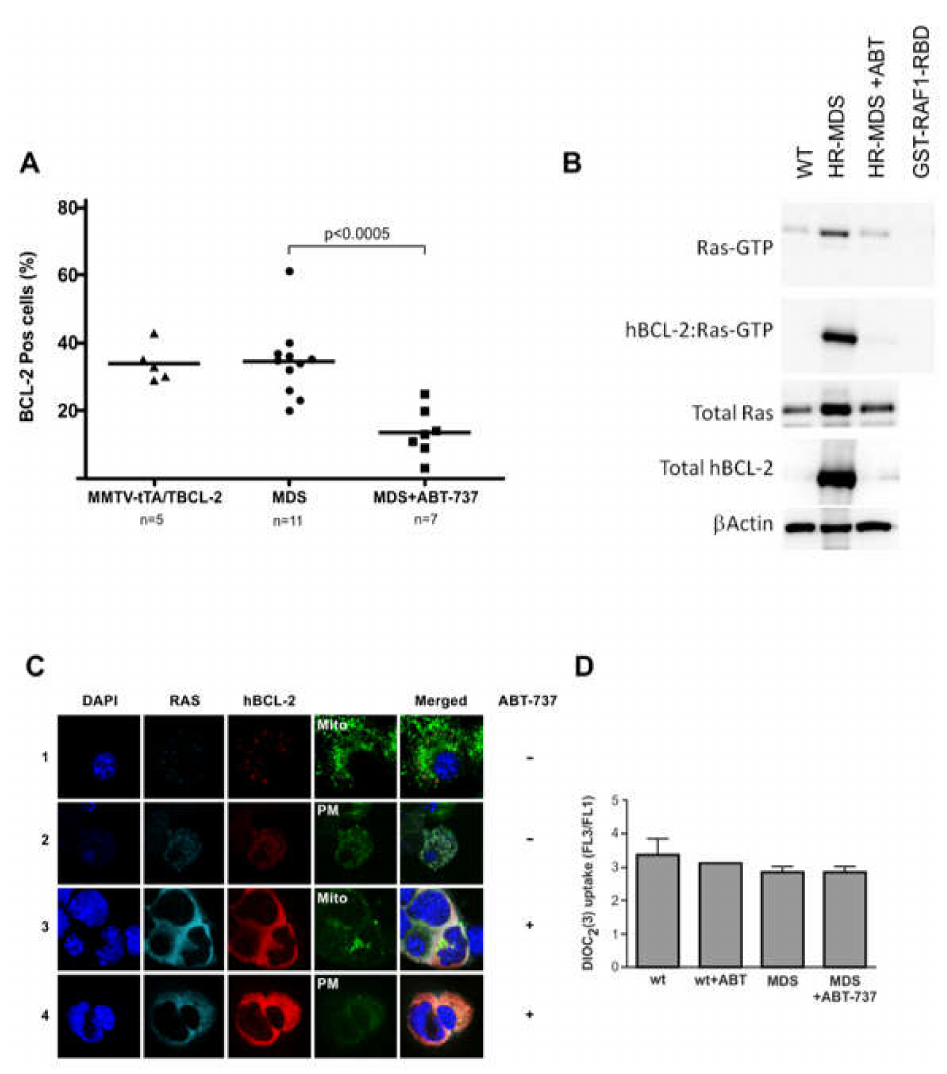
Figure 3. Inhibition of BCL-2 reduces BCL-2 expression and RAS activity in Sca-1+ cells. ( A ) Percentage of peripheral blood hBCL-2 positive (pos) cells in MMTV-tTA/TBCL-2 mice ( n = 5) compared to untreated HR-MDS mice ( n = 11), compared to treated HR-MDS mice ( n = 7), showing a significant decrease of BCL-2 positive cells after treatment p < 0.0005; ( B ) Representative Western blot analysis of protein lysates from Sca-1+ enriched spleen cells of untreated, 75 mg/kg ABT-737 treated mice after day 33 of treatment and assessed for total RAS and hBCL-2 expression showing a decrease in RAS-GTP. Blots were reprobed with anti β -Actin antibody to assess protein loading. n = 3 mice were assayed; ( C ) Confocal microscopy of stained BM cells showing subcellular localization of the NRAS:BCL-2 complex of HR-MDS mice in the plasma membrane in untreated HR-MDS mice (rows 1 & 2) and in treated HR-MDS mice (rows 3 & 4). Mitochondria stained with Tom20 antibody, plasma membrane stained with anti-Ezrin antibody. n = 2 mice were assayed. ( D ) Mitochondrial membrane potential measurements of splenocytes by DiOC2(3) show no difference of dye uptake in ABT-737–treated normal (FVB/N) and HR-MDS mice relative to untreated samples (minimum in each group, n = 3